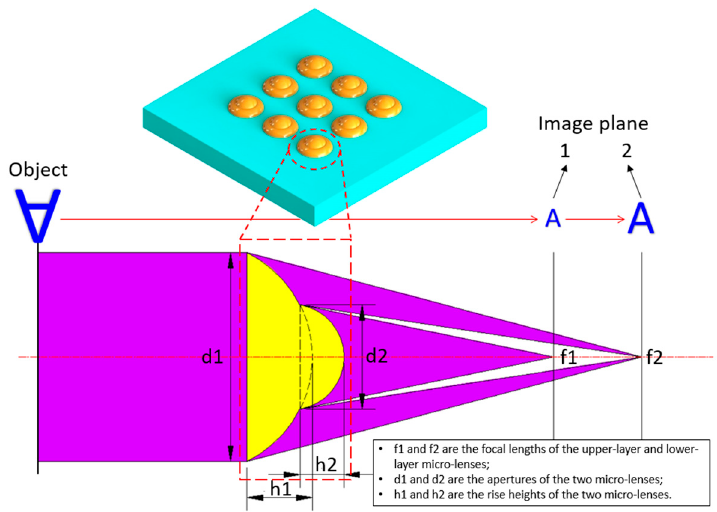
Figure 1. Focusing ability of the MLLAs.